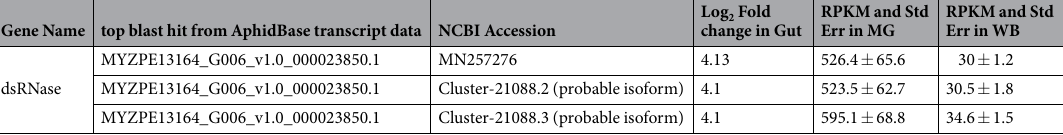
Table 2. Expression level of dsRNases in the midgut (MG) and whole body (WB) of M . persicae . RPKM: Reads Per Kilobase of transcript per million mapped reads, Std Err: Standard Error, FC: Fold